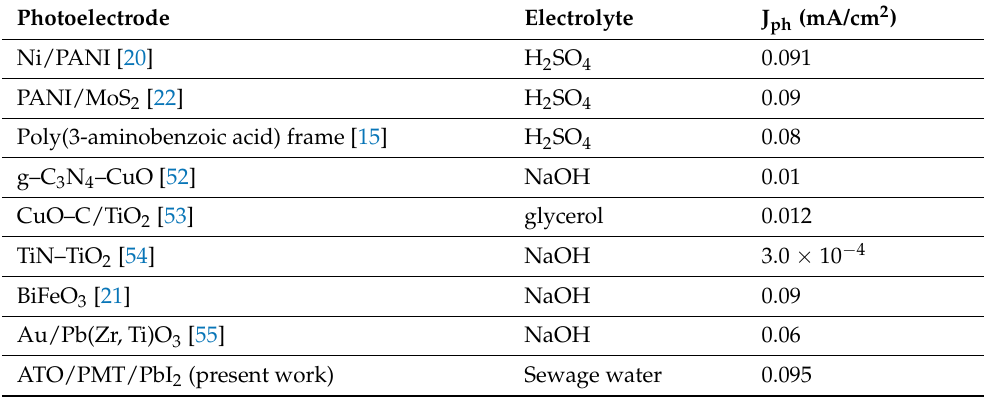
Table 3. The electrolyte used and J ph value of the present work in comparison with the previous